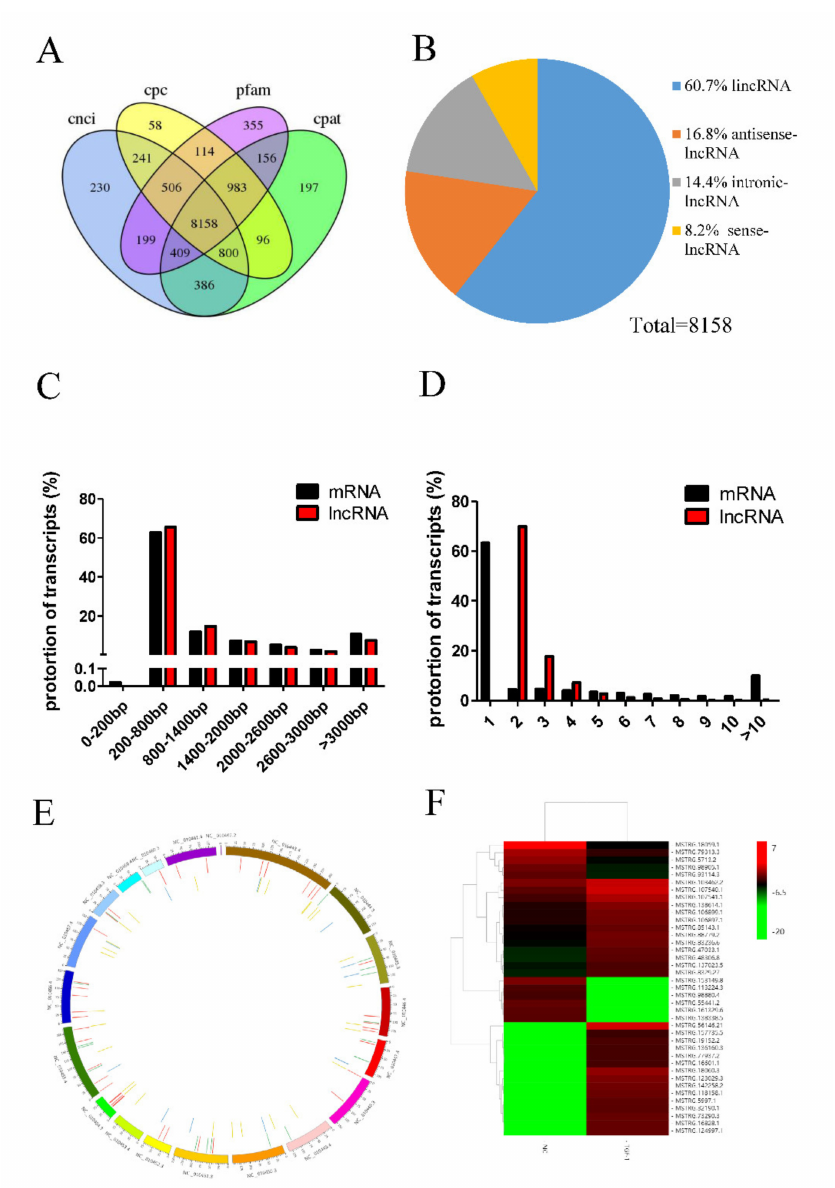
Figure 2. Overview of long noncoding RNA (lncRNA) sequencing data. ( A ) The CNCI(Coding-Non- Coding Index), Pfam database, CPC (Coding Potential Calculator)Tools, and CPAT (Coding Potential Assessment Tool)were used to predict the potential coding capability of lncRNAs to identify lncRNAs. ( B ) Types of predicted lncRNAs. Distribution of sequence length ( C ) and exon number ( D ) of lncRNAs and mRNAs. ( E ) The distribution of lncRNAs and mRNAs on porcine chromosomes. ( F ) Heat maps were constructed to show di ff erentially expressed lncRNAs in two di ff erent